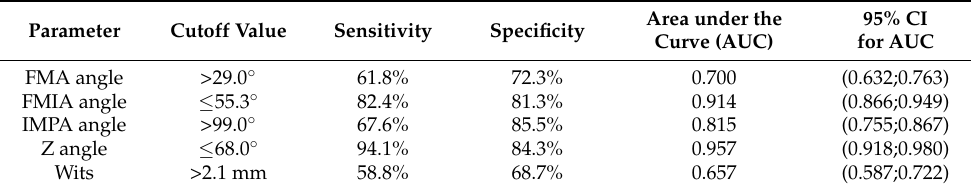
Table 9. The results of the analysis of the ROC curves.